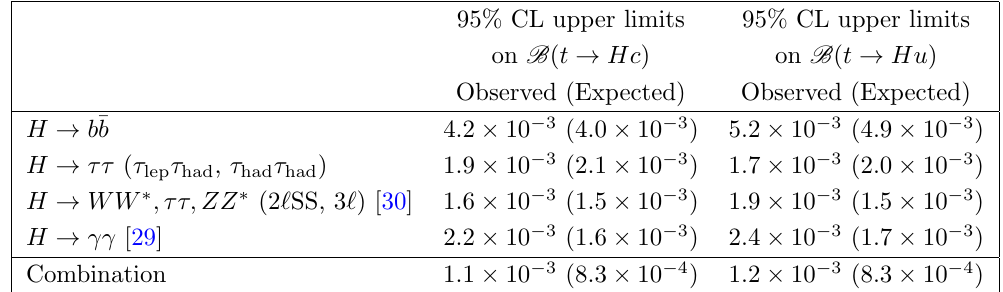
Table 3 . Summary of 95% CL upper limits on B ( t ! Hc ) and B ( t ! Hu ), in each case neglecting the other decay mode. Signatures with two same-charge (three) leptons and no (cid:28) had candidates are denoted by 2 ‘ SS (3 ‘ ).